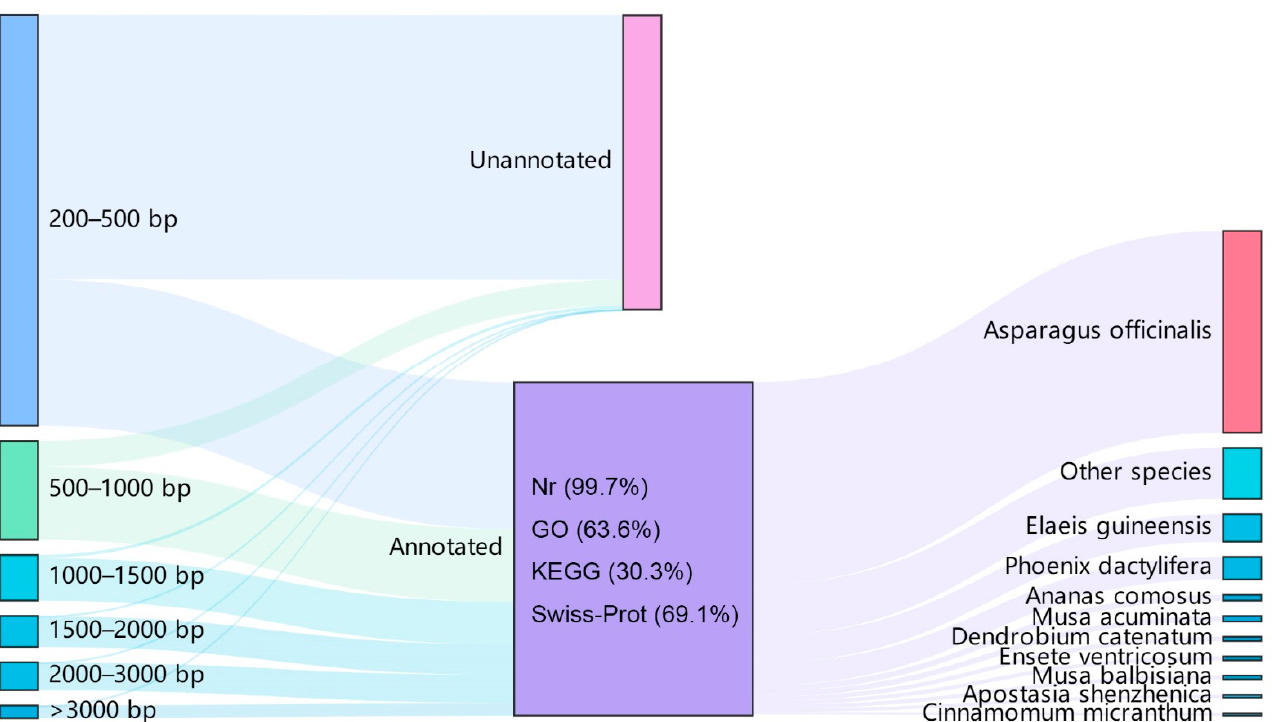
Figure 1. Sequence length distribution and function annotation of A. angustifolia unigenes and their closest homologs in the species of the Nr results.